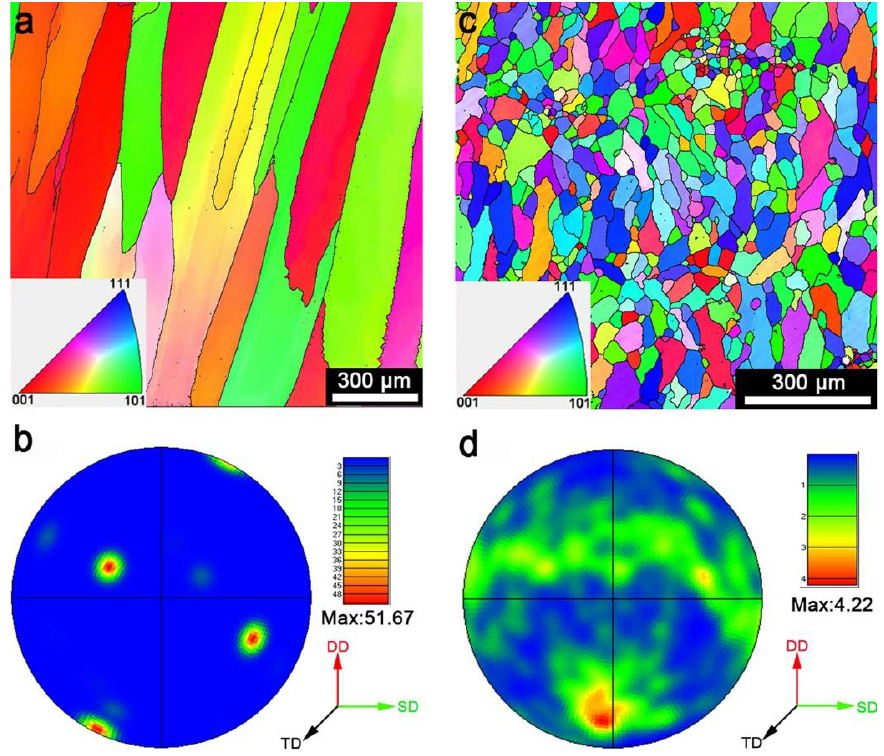
Figure 2. ( a ) The IPF coloring map and ( b ) PF maps of the DED-fabricated CoCrFeNi samples. ( c ) The IPF coloring map and ( d ) PF maps of the DED-fabricated CrMnFeCoNi samples. The microstructure morphology is revealed to depend on the degree of undercooling.